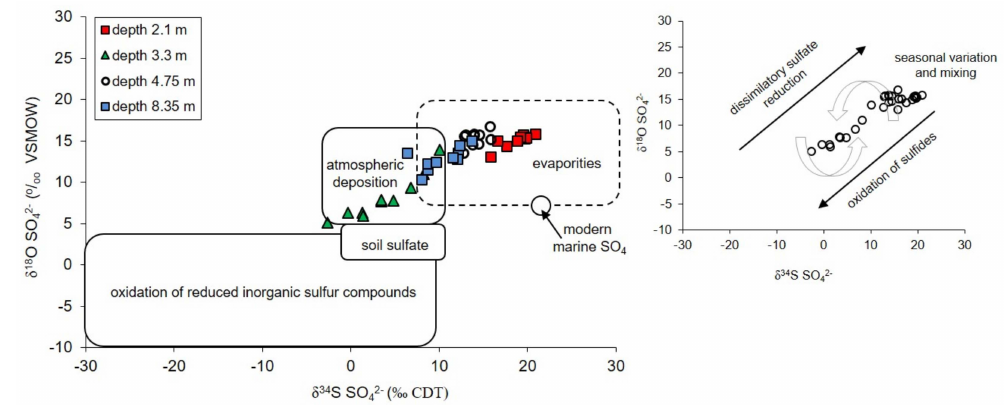
Figure 11. The δ 34 S versus δ 18 O of dissolved SO 42 − in groundwater of unconfined sandy aquifer against the background of typical sulfate sources and trends of biogeochemical